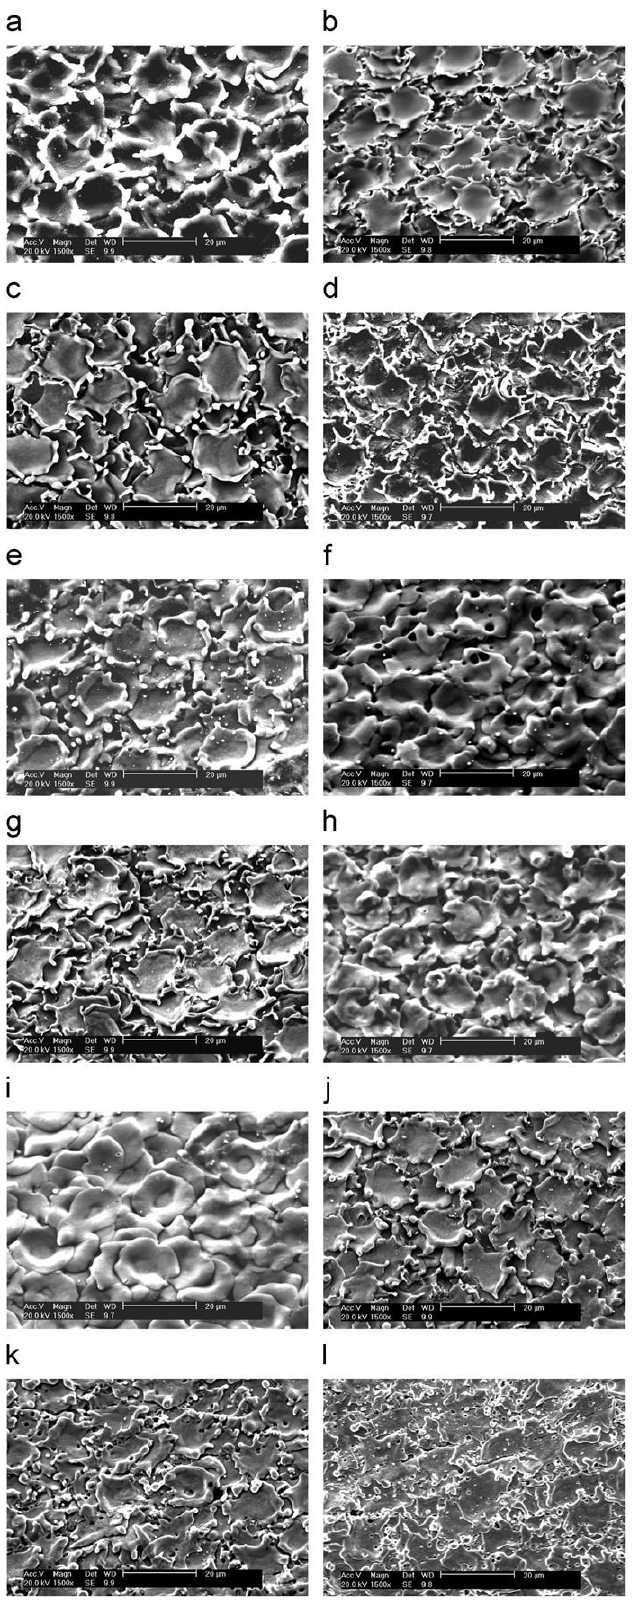
Figure 30. SEM images of the discharge craters for different workpiece materials: ( a ) aluminium (Al), ( b ) silver (Ag), ( c ) brass (Br), ( d ) copper (Cu), ( e ) nickel (Ni), ( f ) steel (Fe), ( g ) platinum (Pt), ( h ) titanium (Ti), ( i ) stainless steel, ( j ) tantalum (Ta), ( k ) molybdenum (Mo) and ( l ) tungsten (W) [203].